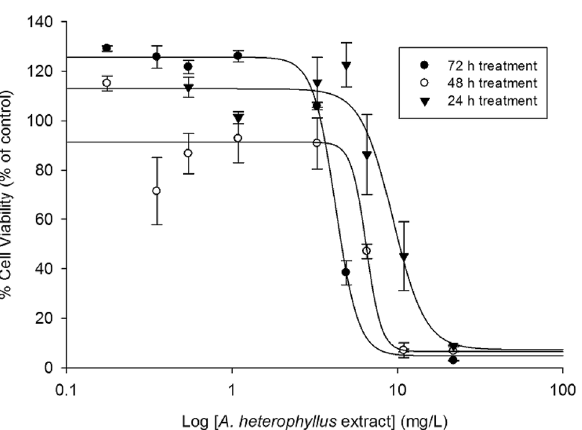
pled with DSS-induced colonic inflammation, thereby mimicking colitis-associated tumorigenesis (see scheme of animal experiment in Fig. 4a). Oral administration of 480 ppm A. heterophyllus extract suppressed AOM/DSS-induced colon tumorigenesis by 46.2%. Compared with vehicle-treated AOM/DSS mice, the A. heterophyllus extract-treated mice had a sig- nificantly (p = 0.0270) lower number of tumors per mouse, particularly those with a diameter of ~ 1 mm (Fig. 5a). The extract was well tolerated, with no fatalities observed within the test group. Immunohistochemical staining showed that treatment with the A. heterophyllus extract reduced the protein expression of tumorigenic marker proliferating cell nuclear antigen (PCNA) in the colon tissues (Fig. 5b). Furthermore, treatment with the A. het- erophyllus extract significantly reduced the gene expression of a series of protumorigenic and proinflammatory genes ( Axin2 ( p = 0.0379), Pcna ( p = 0.0263) , Il-6 ( p = 0.0174) , and Myc ( p = 0.0189)), while a substantial ( albeit